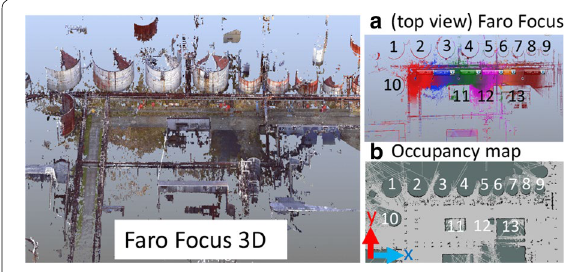
Fig. 8 Faro Focus 3D map measured for a locally consistent refer- ence. a Faro Focus top view. b Example of the mapping result from the RBPF approach